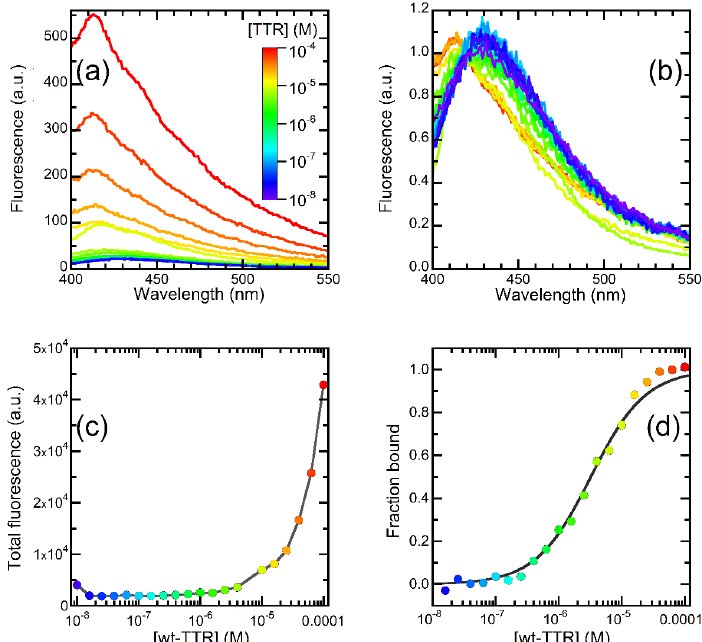
Figure 3. OleA-wt-TTR interaction. ( a ) Fluorescence emission spectra of OleA in the presence of increasing concentrations of wt-TTR in the 1 × 10 −8 M-10 −4 M range. The color varies from blue to purple as the protein concentration increases from 1 × 10 −8 M to 1 × 10 −4 M, as shown in the color scale. ( b ) The same spectra shown in panel ( a ), normalized to the signal emitted at 420 nm to high- light the blue shift of the emission we observed on increasing wt-TTR concentration. Color scale as in panel ( a ). ( c ) Total emission intensities of the spectra reported in panel ( a ) plotted vs. wt-TTR concentration. The concentration refers to the tetramer. Color scale as in panel ( a ). ( d ) The fraction of wt-TTR bound to OleA plotted vs. wt-TTR concentration. The concentration refers to the tetramer. We calculated the fraction bound from the analysis of the blue shift of the emission, as reported in the Methods section. Color scale as in panel ( a ).